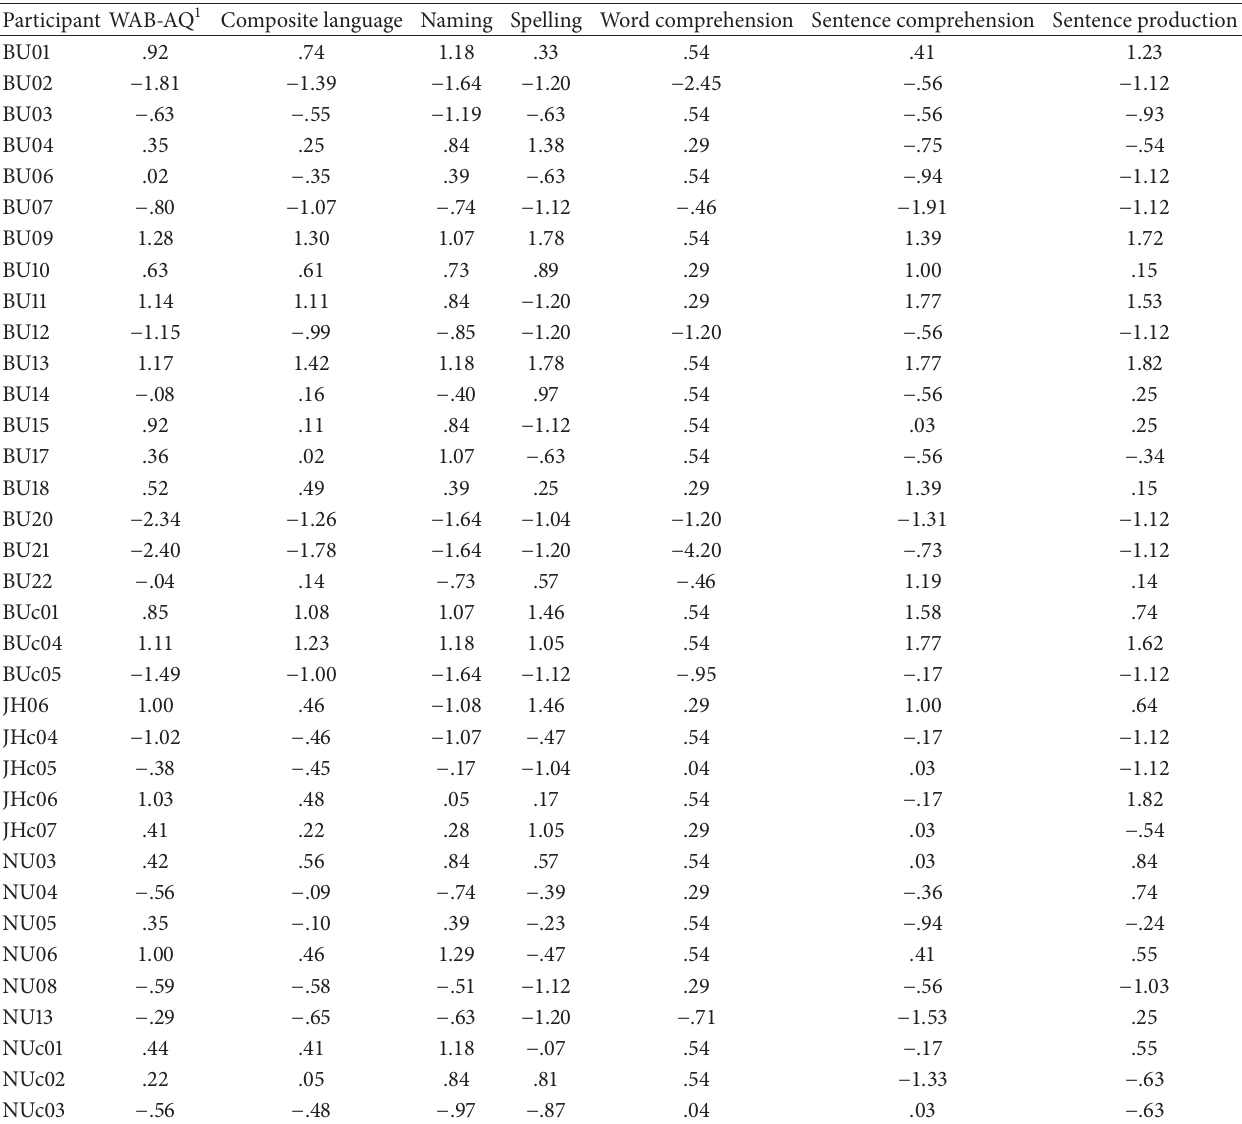
Table 3: WAB Aphasia Quotients (AQ), language domain scores, and composite language scores (as 𝑧 -scores) for each participant with